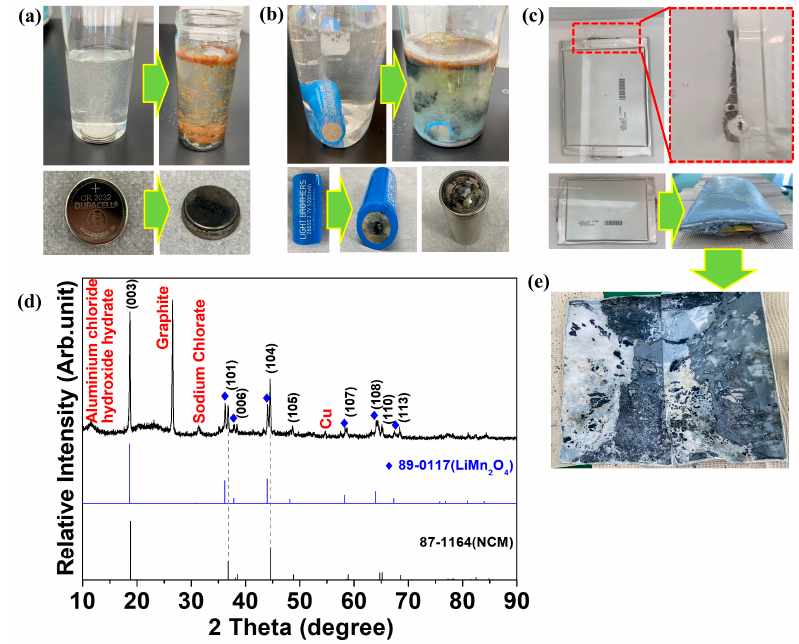
Figure 3. Discharge in salt water (10% NaCl) of a ( a ) coin cell, ( b ) cylindrical cell, and ( c ) pouch cell. The green arrows indicate the changes after immersing the cells in salt water. ( d ) X-ray diffraction analysis of the cathode from the swelled pouch cell after the discharge. ( e ) The photograph of the disassembled pouch cell after the salt water-based discharge.